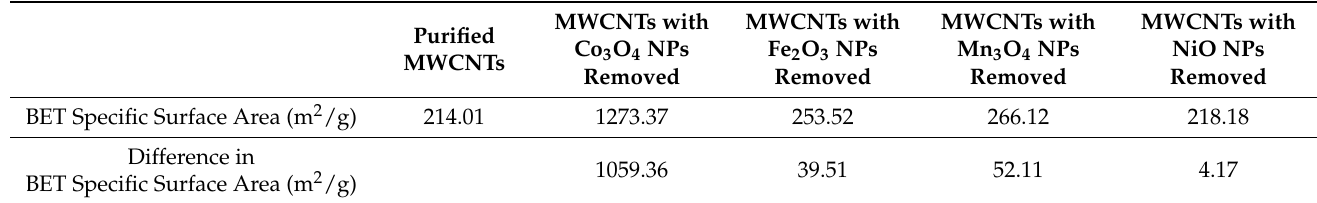
Figure 7. BET specific surface area and BJH pore size distribution of ( a ) purified MWCNTs and multi ‐ vacancy ‐ defect MWCNTs after the removal of ( b ) Co 3 O 4 , ( c ) Fe 2 O 3 , ( d )Mn 3 O 4 , and ( e ) NiO NPs. Table 1. BET specific surface areas of purified MWCNTs and multi ‐ vacancy ‐ defect MWCNTs after removal of metal oxide NPs.